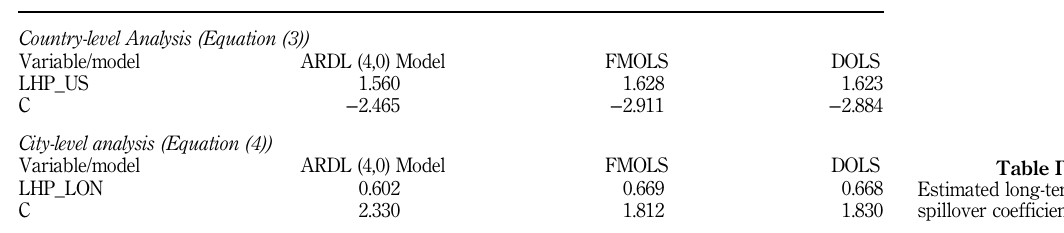
Table IV. Estimated